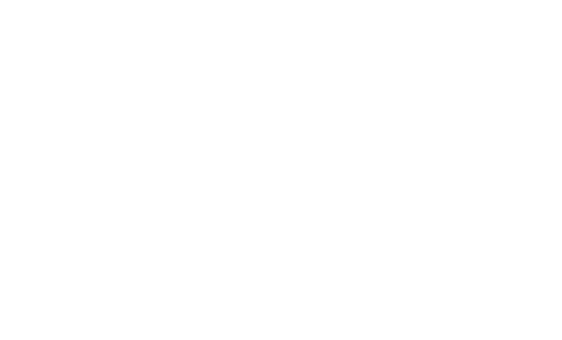
Table 3. The environmental variables for